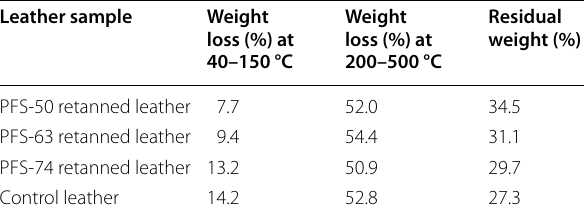
Table 5 Weight loss of PFSs retanned leathers and control leather at different stages and residual weight Leather sample Weight loss (%) at